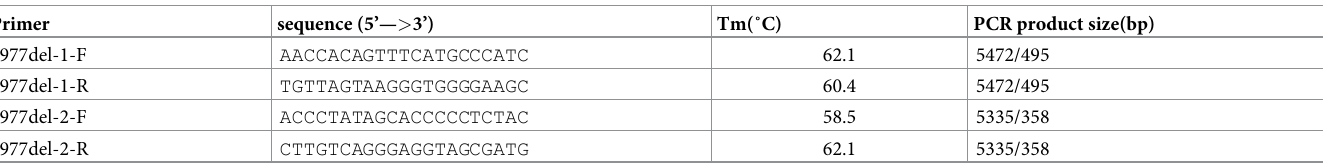
Table 1. Primers using sequencing for nested PCR.